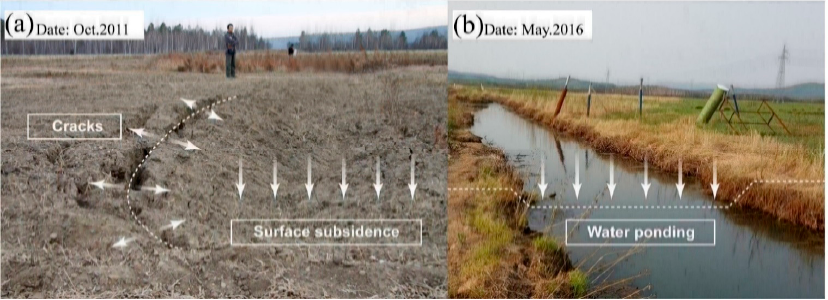
Figure 1. ( a ) Natural ground surface subsidence along the CRCOP. ( b ) Water ponding on the ROW along the CRCOP.